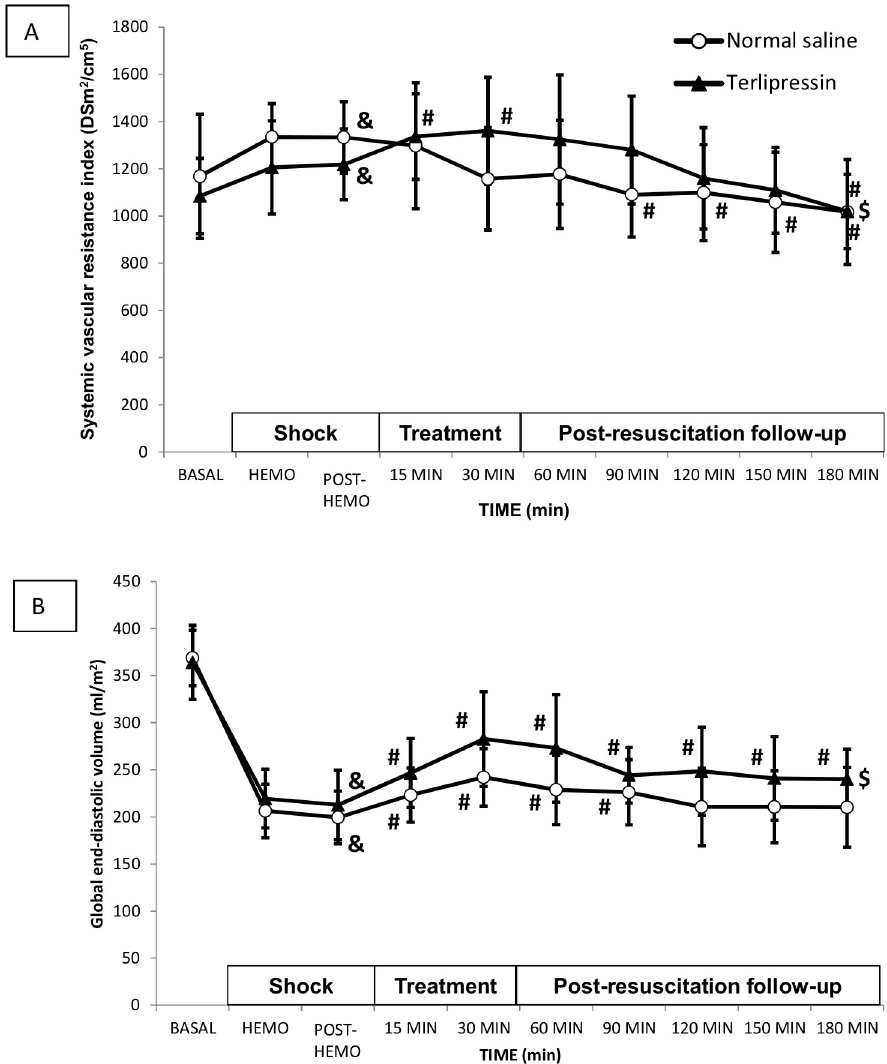
Fig 3. (A) Systemic vascular resistance index (SVRI) and (B) global end-diastolic volume index (GEDI) in normal saline group (white circles) and terlipressin group (black triangles). Data are expressed as mean and SD. ($) p < 0.05 two-factor ANOVA; ( & ) p < 0.05 Hemo vs. basal time point in the same group; ( # )p < 0.05 treatment time points vs. Hemo in the same group.